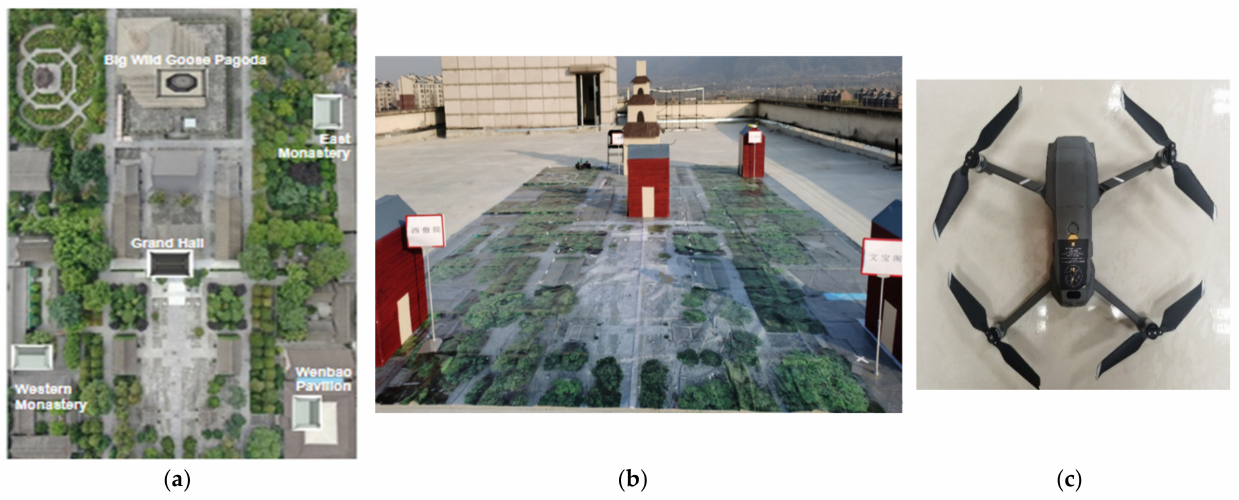
Figure 4. ( a )Aerialphotoofthelocalpagoda. ( b )Experimentalenvironment. ( c